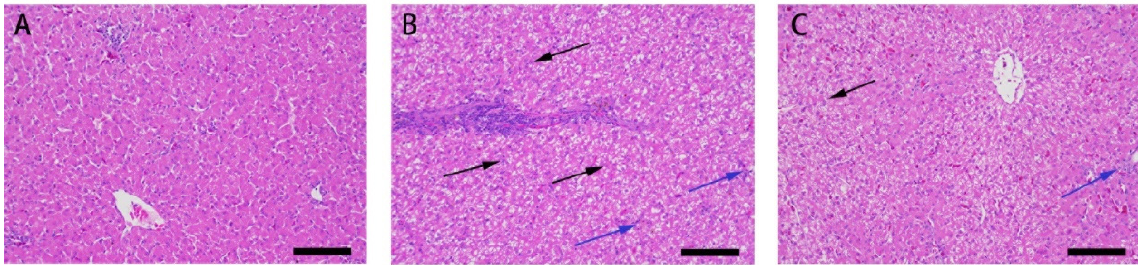
Figure 1. Effect of Res on the microstructure of duck liver exposed to AFB1 (magnification 200 × ). ( A ) the control group; ( B ) the AFB1 group; ( C ) the AFB1 + Res group. The black arrowheads indicate swollen liver cells, and the blue arrowheads indicate inflammatory cell infiltration.